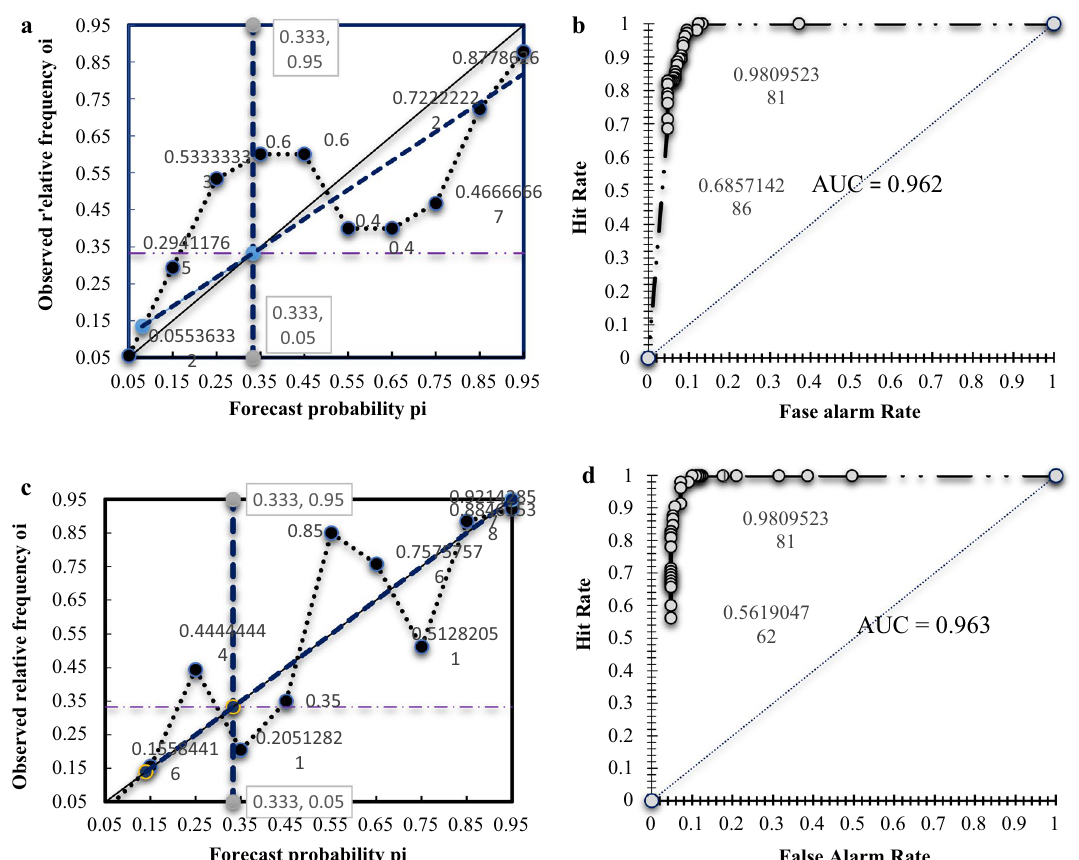
Fig. 9 Attribute diagram and ROC curve for both RAWEns and